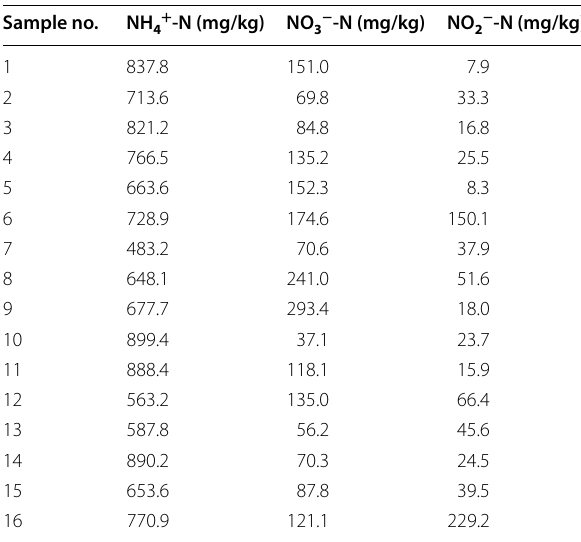
Table 1 Contents of NH tailings of rare-earth-element mines Sample no.